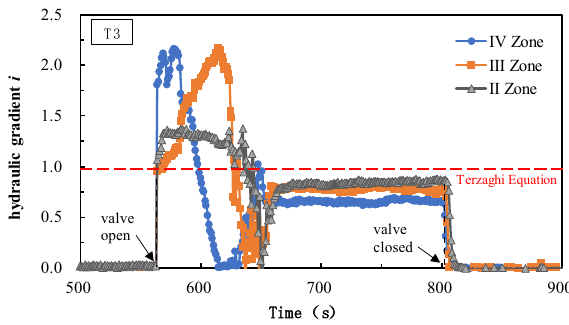
Figure 4. Variation curve of the hydraulic gradient in T3.